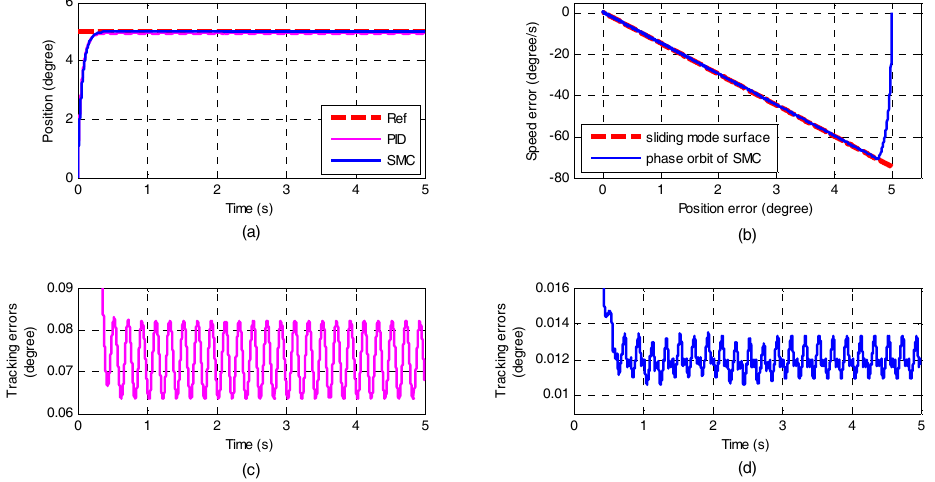
Figure 5. Simulation of step response of Joint 2: ( a ) Position tracking; ( b ) Phases trajectory diagram of SMC; ( c ) Tracking error of PID; and ( d ) Tracking error of SMC.